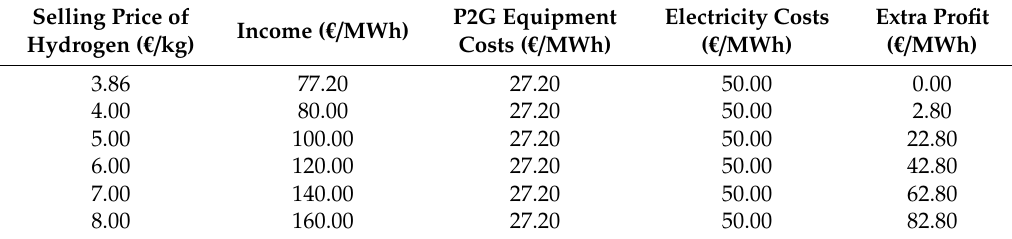
Table 4. Profit at di ff erent selling prices of